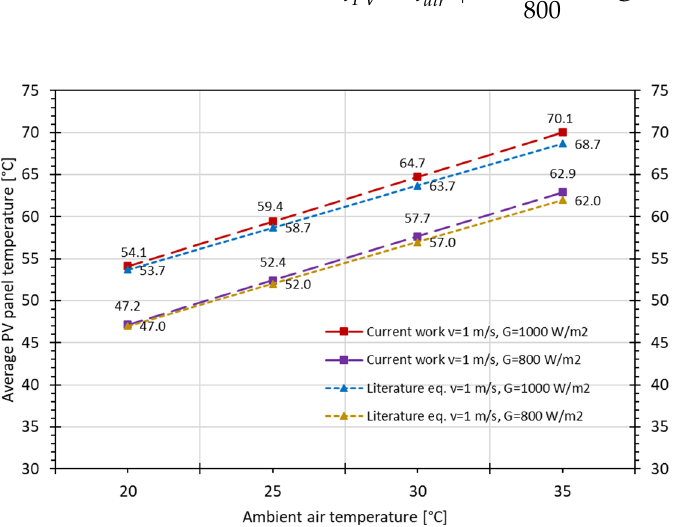
Figure 5. Validation of the numerical model using NOCT conditions and Equation (1).